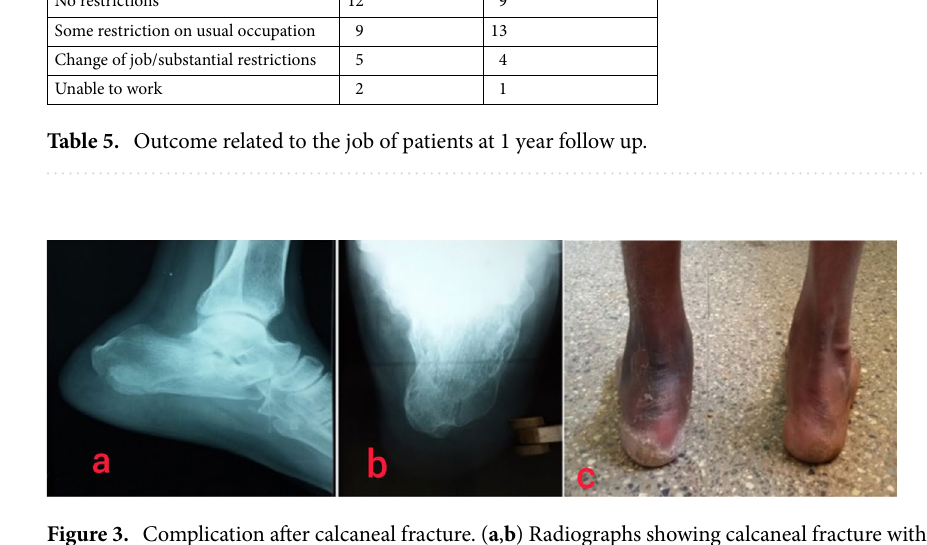
Figure 3. Complication after calcaneal fracture. ( a , b ) Radiographs showing calcaneal fracture with valgus deformation, ( c ) clinical photo of a patient with heel valgus